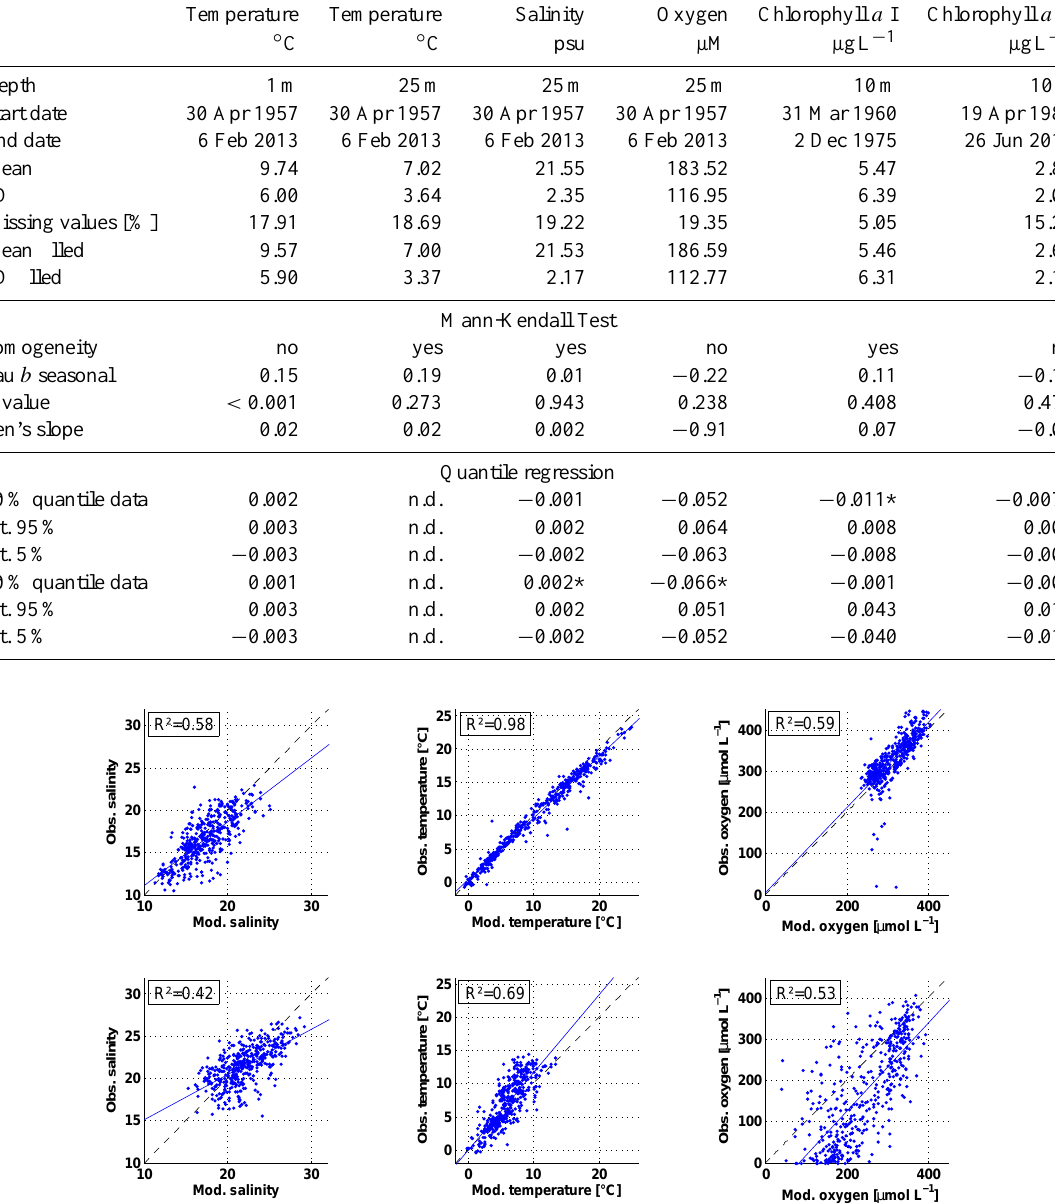
Figure 8. Linear regression of model output (BSIOM at location of BE) vs. observations (BE time series) for salinity, temperature and oxygen concentration. The first row shows surface, the second one bottom layer comparison. Note that in the model, the bottom layer is 21–24 m while it is 25 m in the observations. Obs. = Observation, Mod. = Model output.